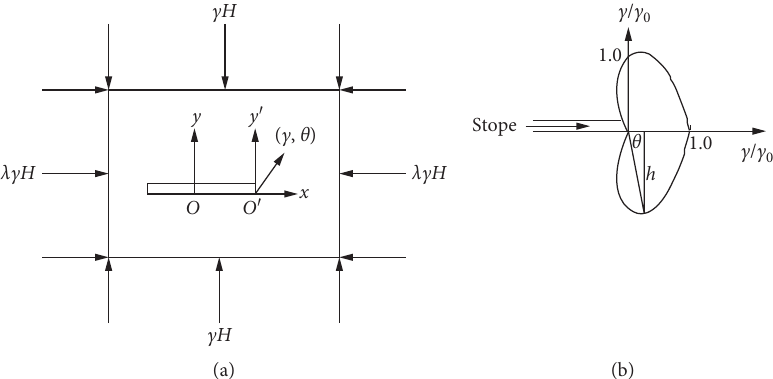
Figure 4: Stope mechanical model of plastic theoretical.